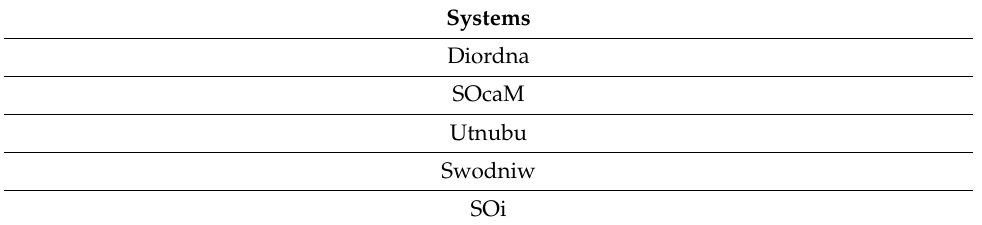
Table 4. Formal context Systems for the fictitious example. It has no